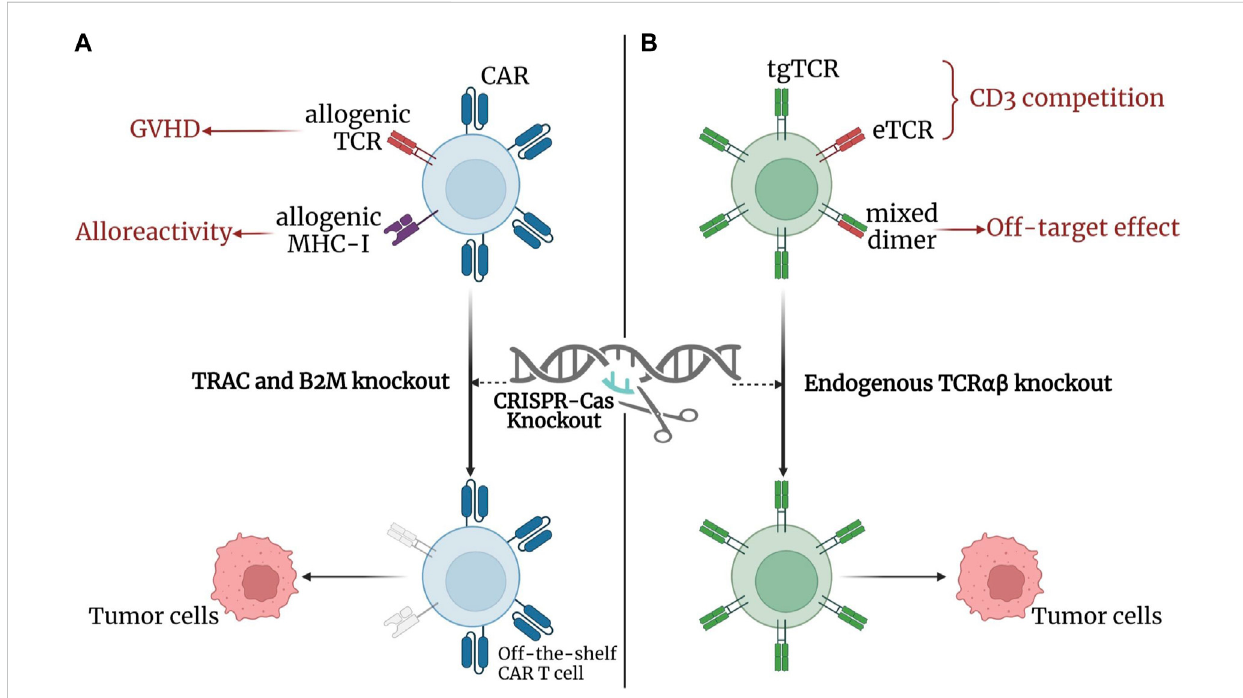
FIGURE 9 CRISPR-Cas inadoptiveTcell therapy. (A) CRISPR-Cas inCART-celltherapy:knockdownofTRAC andB2MusingCRISPRreducestherisk ofGVHD and limits the alloreactivity of allogenic T cells, respectively, thus improving the anti-tumor ef fi cacy and safety of CAR-T cell therapy. The fi ndings contributes to the establishment of off-the-shelf CAR-T cells. (B) CRISPR-Cas in TCR T-cell therapy: knockdown of endogenous TCR αβ with CRISPR reduces the binding competition and mismatch between tgTCRs and eTCRs, thus reducing off-target effects and increasing the surface expression of tgTCRs. Created with